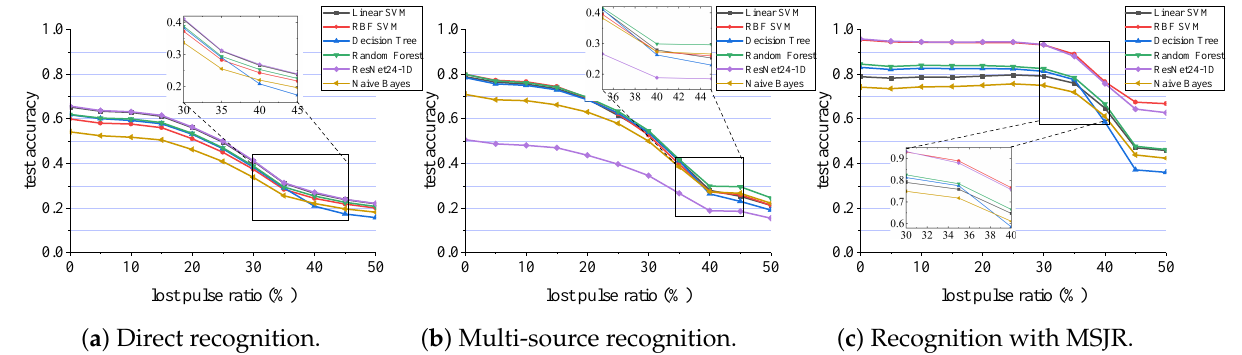
Figure 11. Accuracy curve of mode recognition classifier. ( a ) Directly identified on the original data; ( b ) multiple information sources are used for recognition without feature extraction; ( c ) recognition using the complete MSJR learning